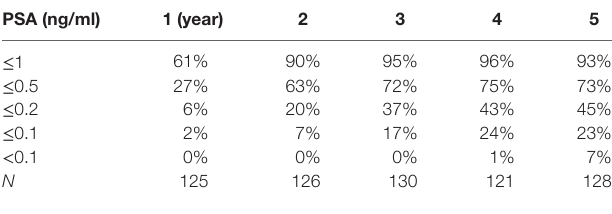
TaBle 3 | The percentage of patients with biochemical RFS reaching a given PSA in the years following stereotactic body radiation therapy.